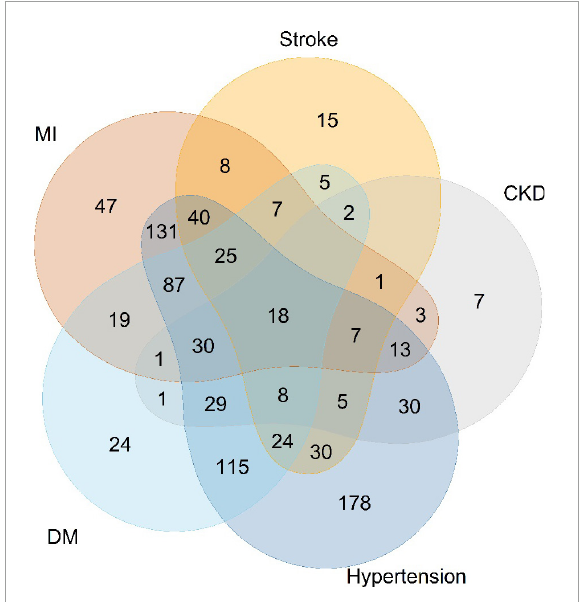
FIGURE2 Numbers of heart-failure patients with different comorbidities. MI, myocardial infarction; CKD, chronic kidney diseases; DM, diabetes mellitus.